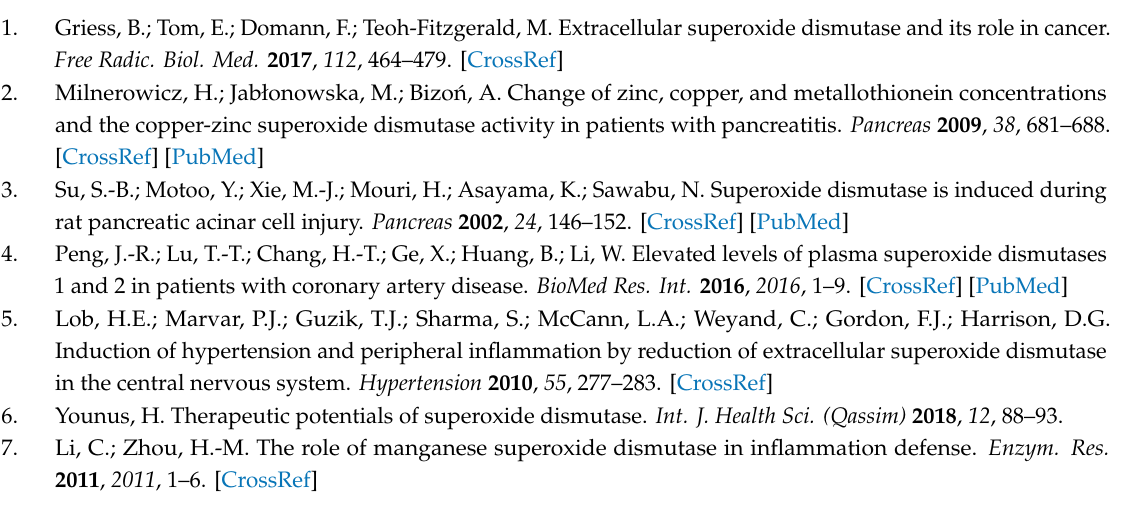
Table S1: The activity of total SOD, the concentrations of metals (Cu, Zn), MDA and hs-CRP in the blood of healthy subjects aged 20–30 and 30–70, Table S2: The activity of total SOD, the concentrations of metals (Cu, Zn), MDA and hs-CRP in the blood of individuals in 20–30 years old divided in terms of gender, Table S3: The activity of total SOD, the concentrations of metals (Cu, Zn), MDA and hs-CRP in the blood of individuals in 30–70 years old divided in terms of gender, Table S4: The activity of total SOD, the concentrations of metals (Cu, Zn), MDA and hs-CRP in the blood of individuals in aged 20–30 divided in terms of the exposure to tobacco smoke xenobiotics, Table S5: The activity of total SOD, the concentrations of metals (Cu, Zn), MDA and hs-CRP in the blood of individuals in aged 30–70 divided in terms of the exposure to tobacco smoke